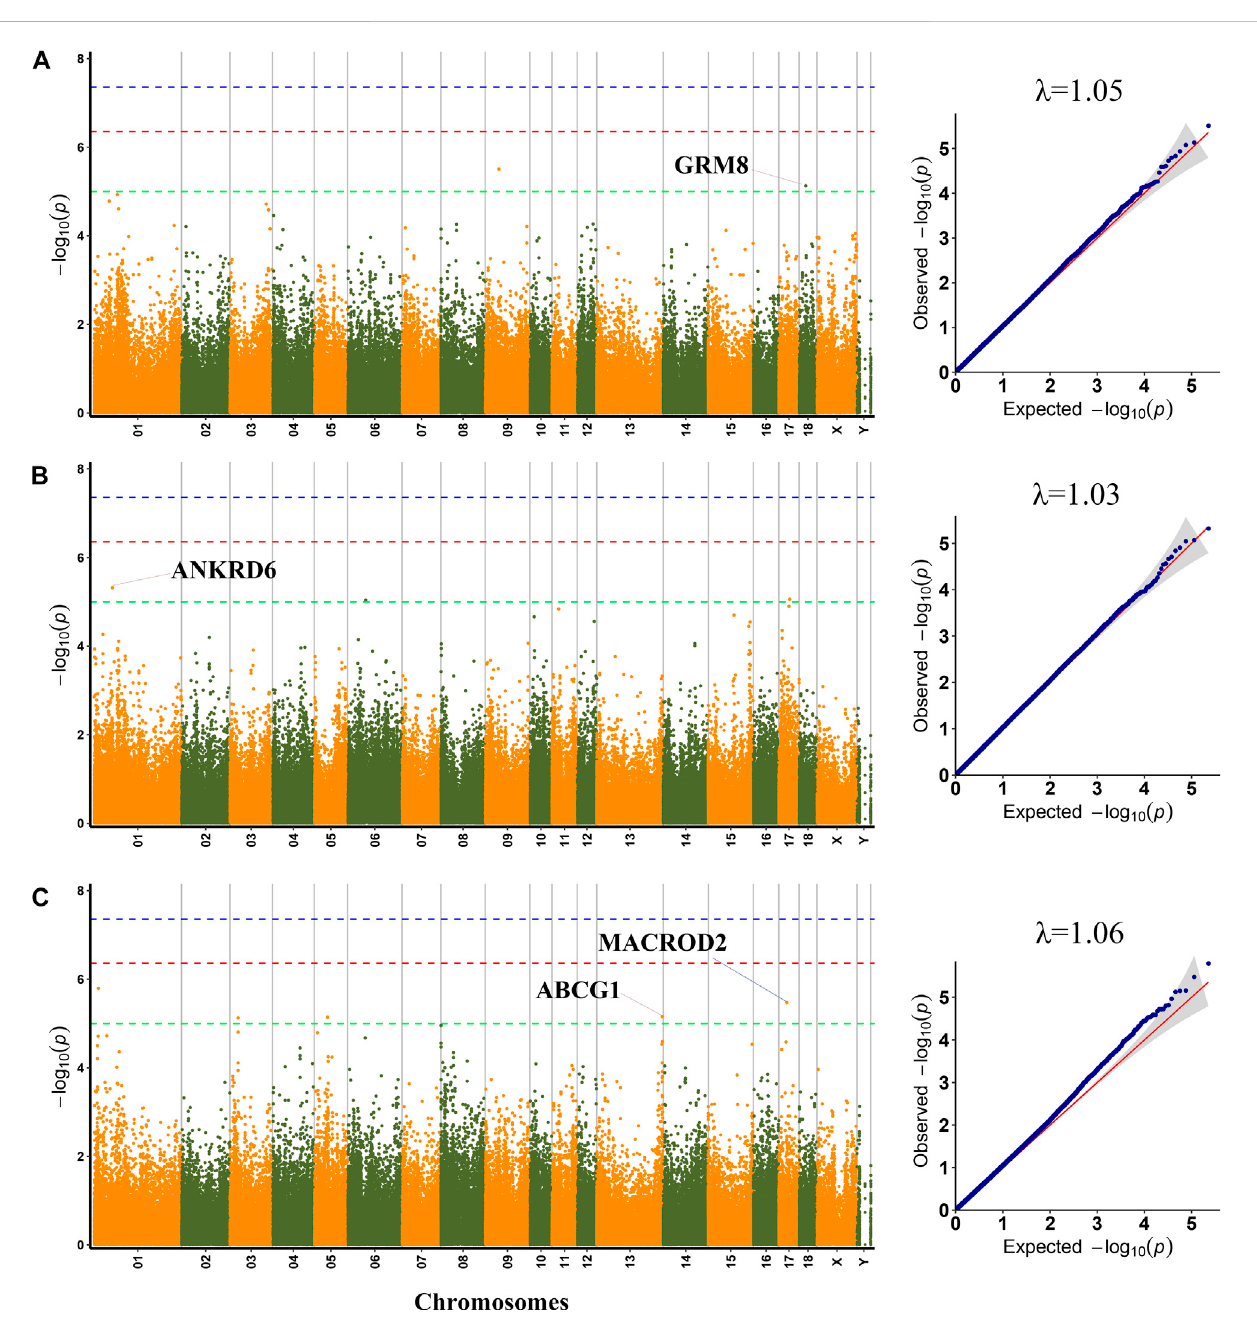
FIGURE 1 Manhattan plots and QQ plots for pH45, MC and MA using MLM. (A) pH45 (B) MC (C) MA. Negative log 10 p -value of the fi ltered high-quality SNPs were plotted against their genomic positions; The dashed lines of green, orange and blue correspond to the Bonferroni-corrected thresholds of p = 1.00 × 10 −